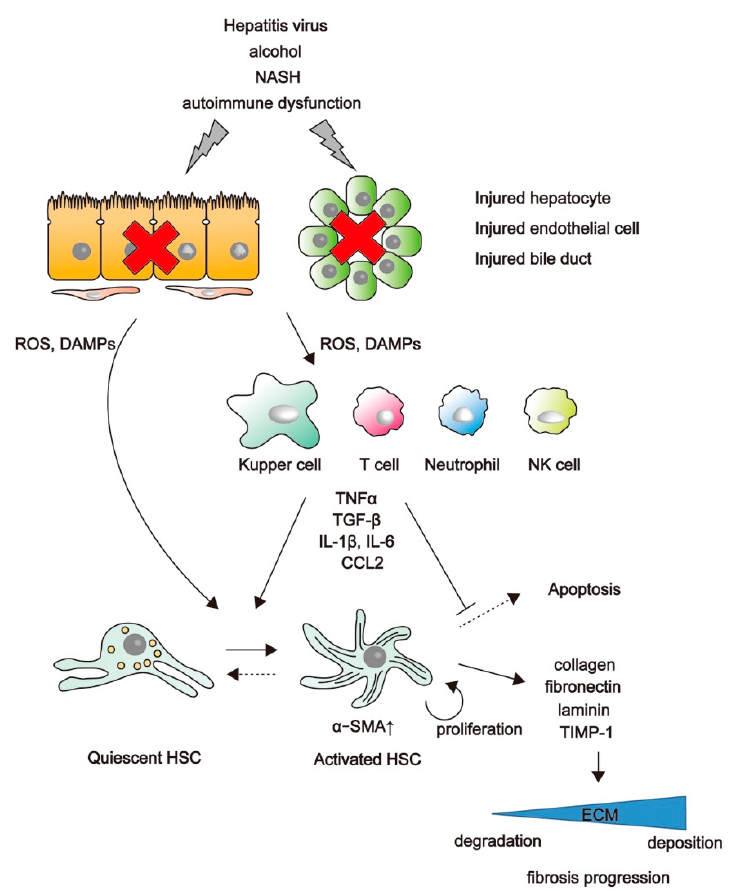
Figure 1. Process of hepatic stellate cell (HSC) activation and liver fibrosis progression. Damaged cells secrete damage-associated molecular patterns (DAMPs) and reactive oxygen species (ROS). These